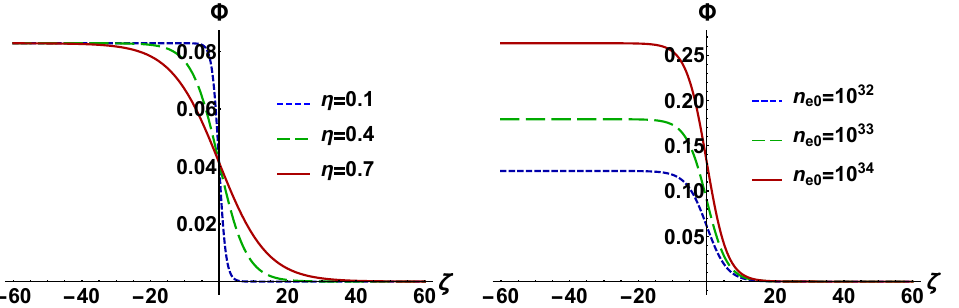
Figure 2. Plot of Φ vs. ζ for different values of η ( left panel ) and for different values of n e panel ) when α = 5/3, δ = 20 ◦ , γ e = 4/3, η = 0.3, Z 1 = 37, Z 2 = 6, n 10 = 10 29 cm − 3 , n 20 = = 10 33 cm − 3 , U = 0.05, and v p = v p + . 10 30 cm − 3 , n e 0 0